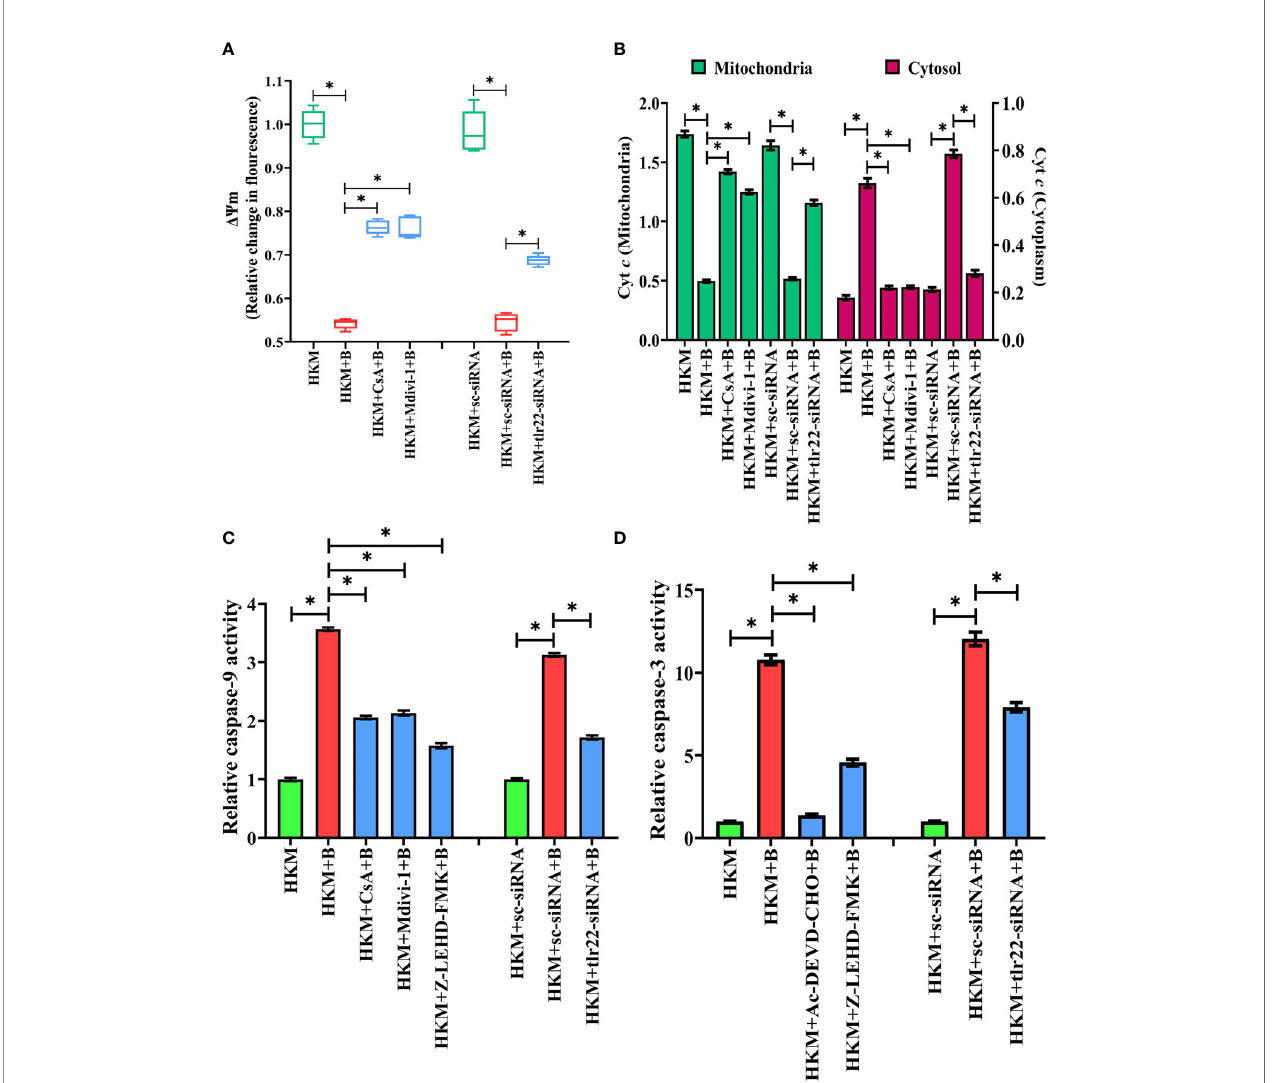
FIGURE 5 | TLR22-induced mitochondrial fragmentation dissipates y m and triggers Cyt c release actvating caspase-9/caspase-3 axis in A. hydrophila -infected HKM. HKM pre-incubated with CsA, Mdivi-1 or transfected with sc-siRNA, tlr22-siRNA were infected with A. hydrophila and at 24 h p.i., (A) changes in y m